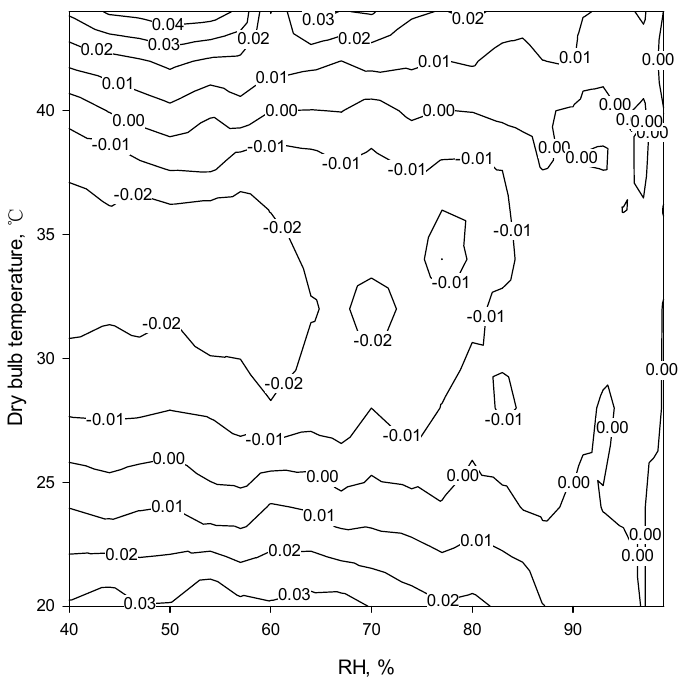
Figure 5. The error distribution for Model II. 4. The Measurement Uncertainty for the Tw Equation For a value of Tw of 35 ◦ C, with the threshold for heat stress at 35 ◦ C, the relationship between Td and RH is shown in Figure